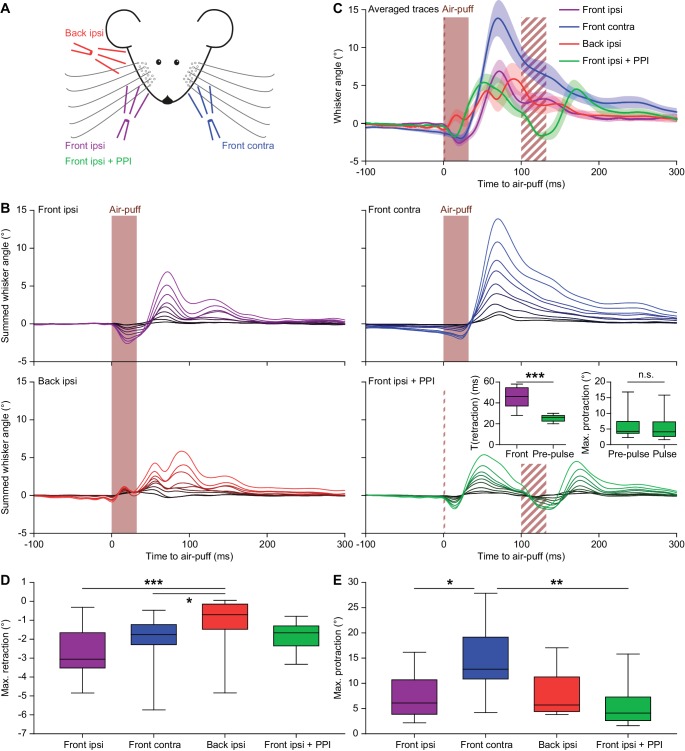
Air-puffs induce reflexive whisker movements.(A) Schematic drawing of the experimental layout. Air-puffs lasting 30 ms were delivered from three different locations. In addition, some air-puffs delivered ipsilaterally from the front were preceded by a brief air-puff (2 ms) 100 ms before the 30 ms air-puff to test for pre-pulse inhibition (PPI). The four stimulus conditions were applied in a random order. (B) For each of the nine mice tested, we calculated the average whisker response (always on the side with the two puffers) and represented these as summed line plots. The stacked line plots are scaled such that the brightest line (on top) depicts the average of all mice. The insets show the duration of the retraction (until the whiskers reached the baseline position again) comparing the 2 ms and the 30 ms pulses (left) and the maximal protraction amplitudes upon the pre-pulse compared to the pulse (right). The retraction upon the short pre-pulse was less intense, but the consecutive protractions were of similar amplitude, indicating the absence of pre-pulse inhibition (p=0.0078 and p=0.4961, respectively; Wilcoxon matched-pairs tests; significance level = 0.025 after Bonferroni correction for multiple comparisons). (C) Overlay of averaged ipsilateral whisker responses with shaded areas indicating ±SEM. The three ipsilateral conditions resulted in similar amounts of protraction. Note that the puff from the back did not cause a retraction preceding the protraction and that the pre-pulse did not affect the size of the protraction following the second air-puff. The brief pre-pulse induced a shorter retraction, but this had no effect on the protraction. Air-puffs to the contralateral whisker pad caused stronger protractions than the ipsilateral stimuli. (D) The maximum retraction was largest when the air-puffer was in front of the ipsilateral whiskers. The shorter pre-pulse did cause a briefer retraction (see inset in B), but the amplitude was not significantly different from the retraction caused by the longer pulse (p=0.268; Dunn’s pair-wise post-hoc test after Friedman’s two-way ANOVA; see Supplementary file 1A). Puffing from the contralateral whiskers or the ipsilateral whiskers from the back caused the least retraction, indicating that the initial retraction is largely passive and caused by the air flow of the stimulator. (E) The maximum protraction reached was similar for all conditions, except in case the contralateral whiskers were stimulated, which led to a stronger protraction on the ipsilateral side. n.s. p>0.05; *p<0.05; ***p<0.001; ***p<0.001. See also Source Data file.10.7554/eLife.38852.006Figure 1—figure supplement 2—source data 1.Data for Figure 1—figure supplement 2.